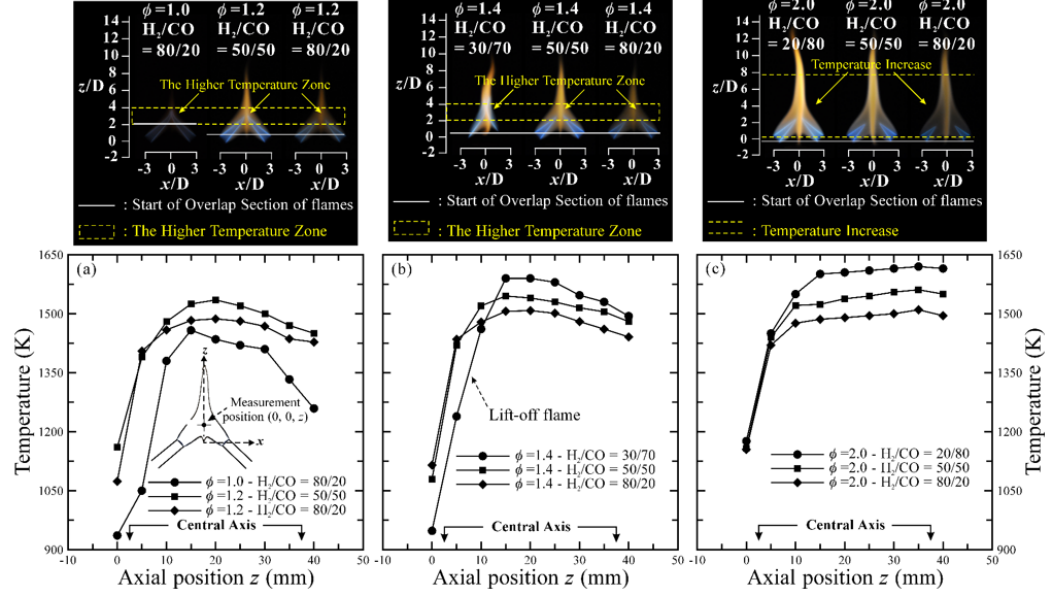
Figure 11. Distribution of axial temperature of CH 4 /syngas/air premixed impinging flames: ( a ) φ = 1.0 and 1.2; ( b ) φ = 1.4; ( c ) φ = 2.0.